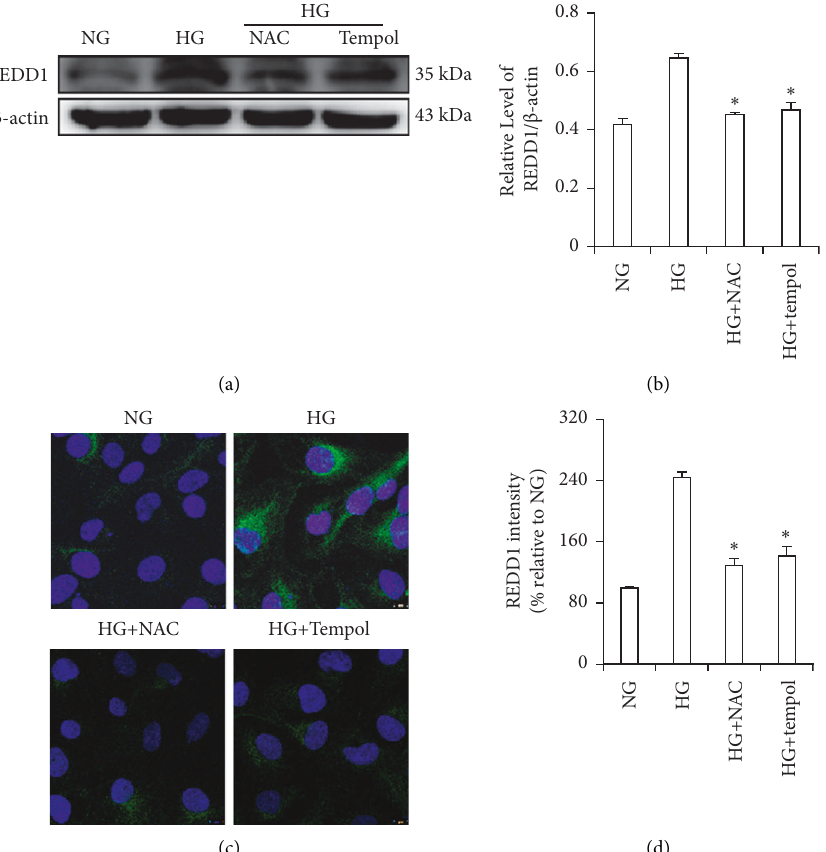
Figure 9: Effects of antioxidant interference on HG-induced REDD1 in HK-2 cells. (a, b) The expression of REDD1 and β -actin was analyzed by western blot in HK-2 cells. (c, d) Immunofluorescence analysis of the expression of REDD1 in HK-2 cells. Values are expressed as means SD ( n 6 per group). NG: 5.6mM D-glucose; HG: 30mM D-glucose; HG+NAC: 30mM D-glucose+ N-acetylcysteine (5mM); (cid:31) HG+ Tempol: 30 mM D-glucose+ Tempol (100 ±